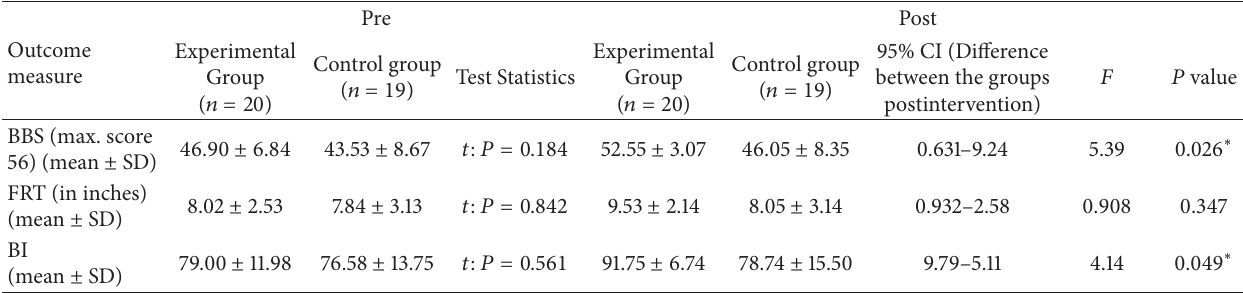
Table 2: Pre- and Postintervention change in outcome measures between the experimental group and control group.